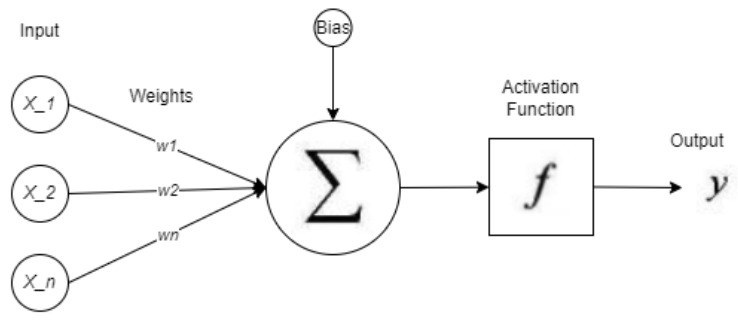
Figure 3. ANN Operation.